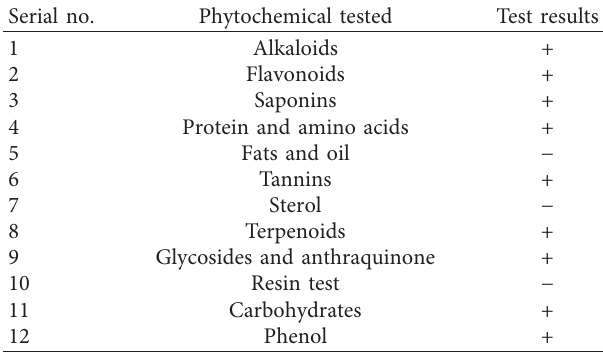
Table 1: Phytochemical screening test results of S. triqueter L. Palla . Serial